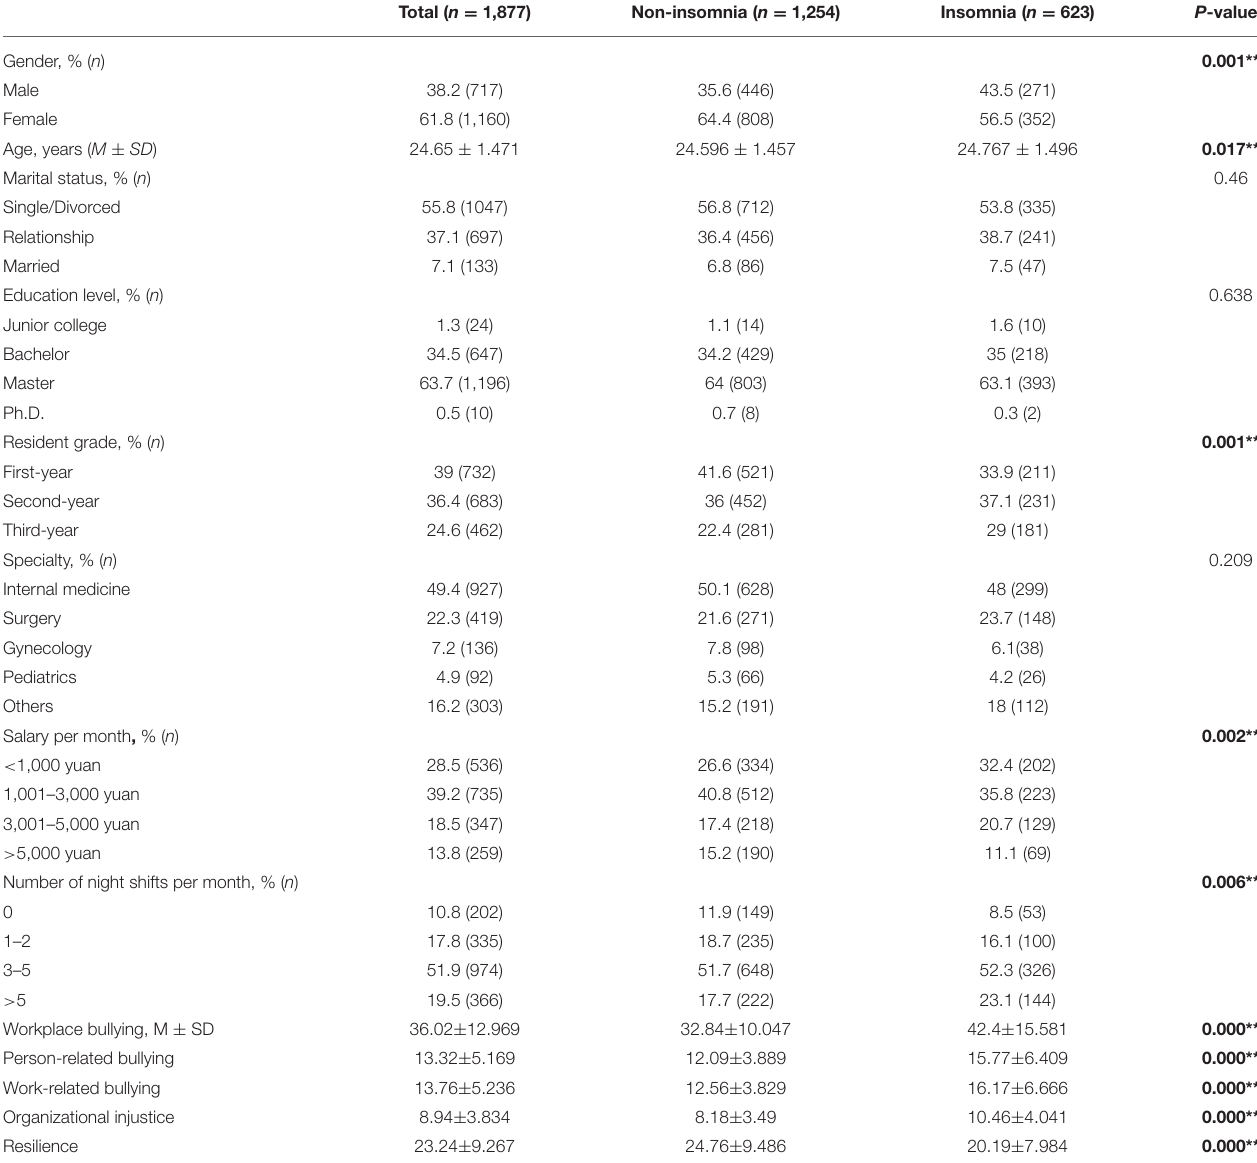
TABLE 1 | Characteristics of the resident doctors in the insomnia group and non-insomnia group. Total ( n = 1,877) Non-insomnia ( n = 1,254) Insomnia ( n = 623) P -values